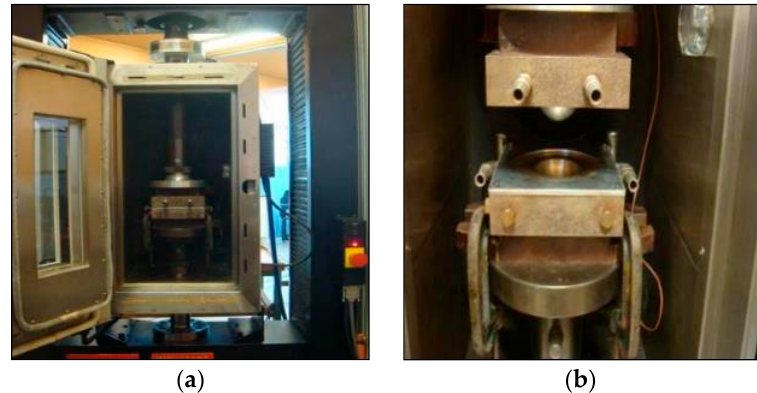
Figure 6. ( a ) Dome forming experimental setup and ( b ) close up of matched-die forming equipment. Table 2. Dome forming test parameters for bamboo fabric-PLA composites using cold and hot tooling